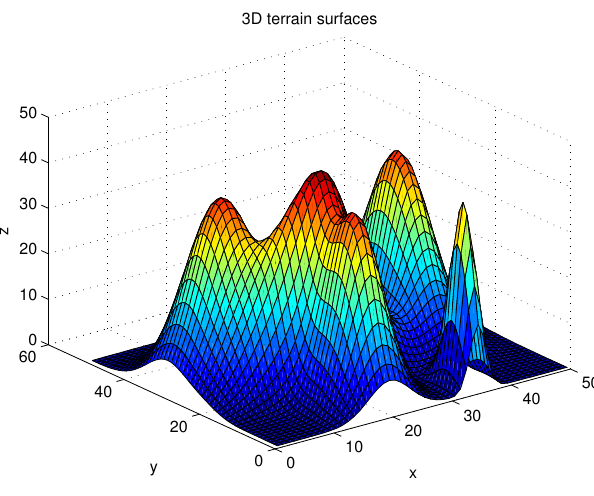
Figure 4. 3D terrain surfaces considered in simulations (Scenario 1).